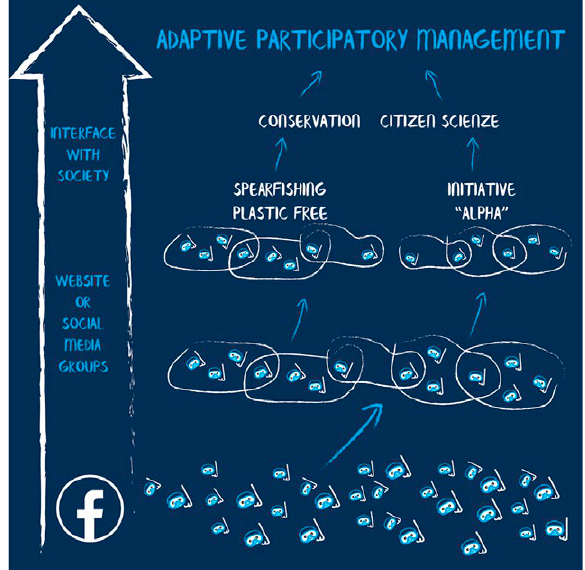
Fig. 1. – A conceptual framework showing the emergence of Plastic- Free Spearfishing. The bottom-up process can be simplified as fol- lows: (i) recreational spearfishers are present as individuals on so- cial media such as Facebook; (ii) they organize themselves in social media groups according to their interests and attitudes; (iii) social media groups are organized in a metagroup with the goal of help- ing to mitigate plastic pollution; ( iv ) they start organizing actions for removing underwater plastic debris (see also Fig. 3) and create an interface with society. Similar initiatives could also emerge for other purposes such as the citizen science initiative shown on the right side of the